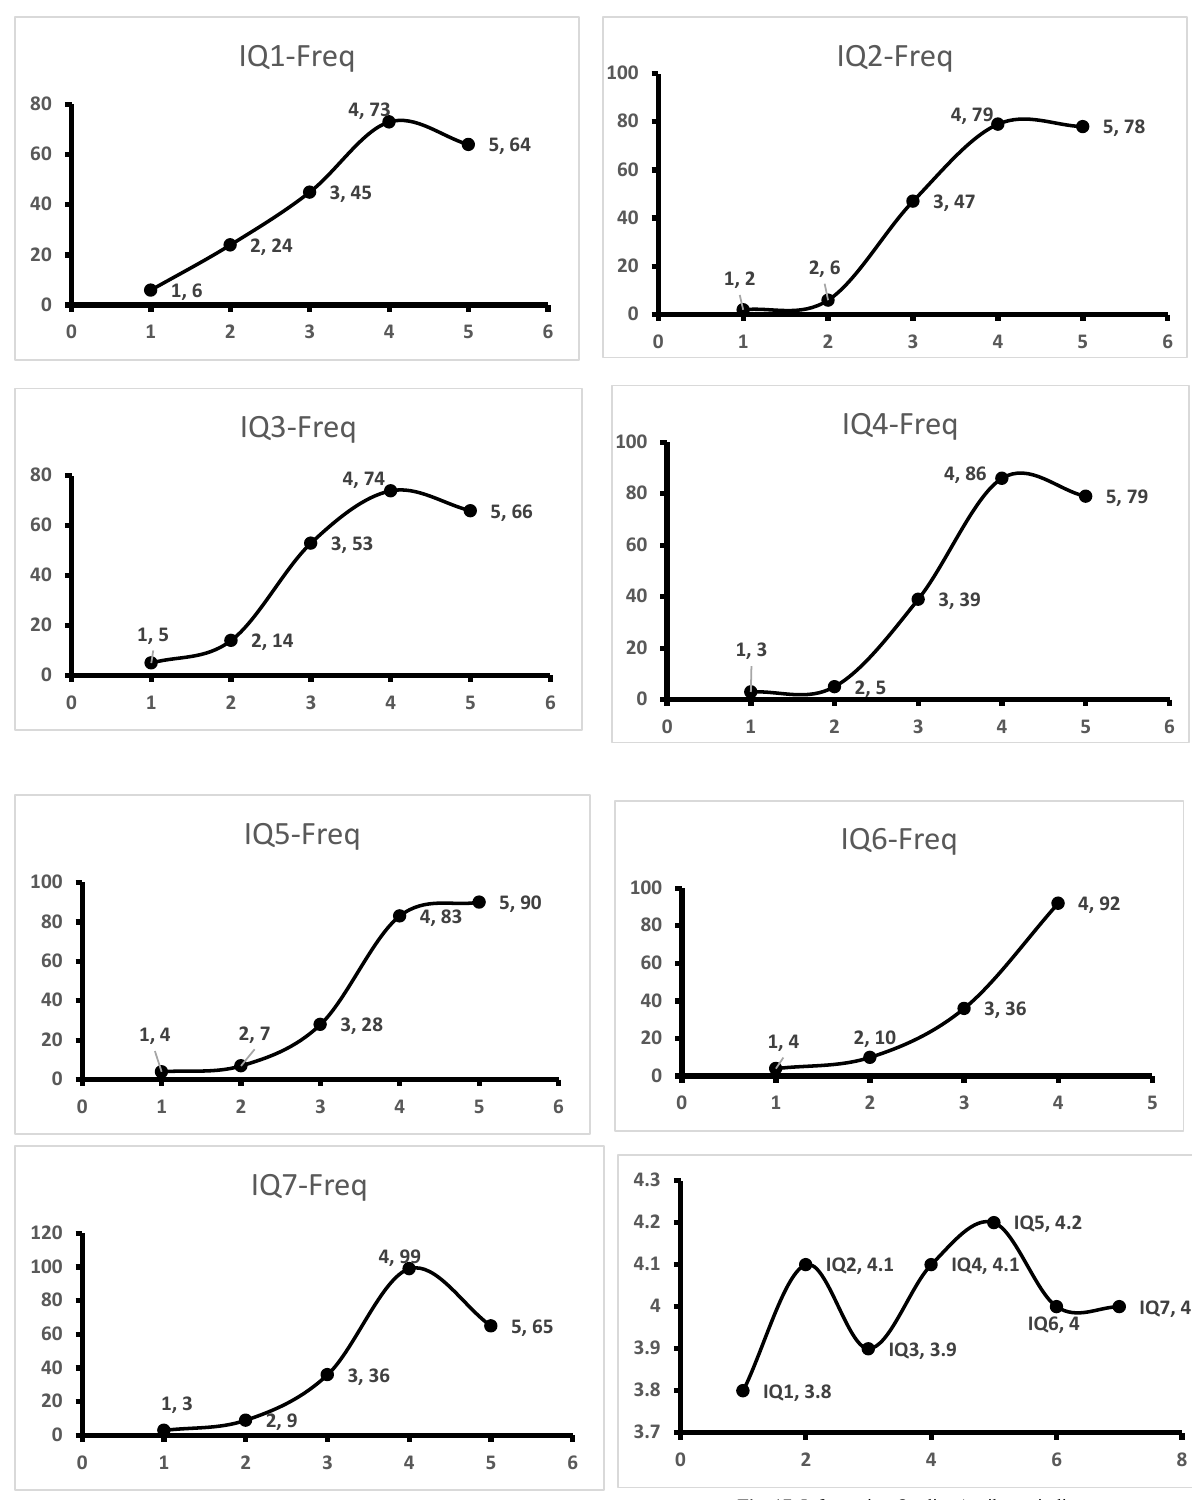
Fig. 17. Information Quality Attributes indicators Figs. [9-16] -Information Quality attributes